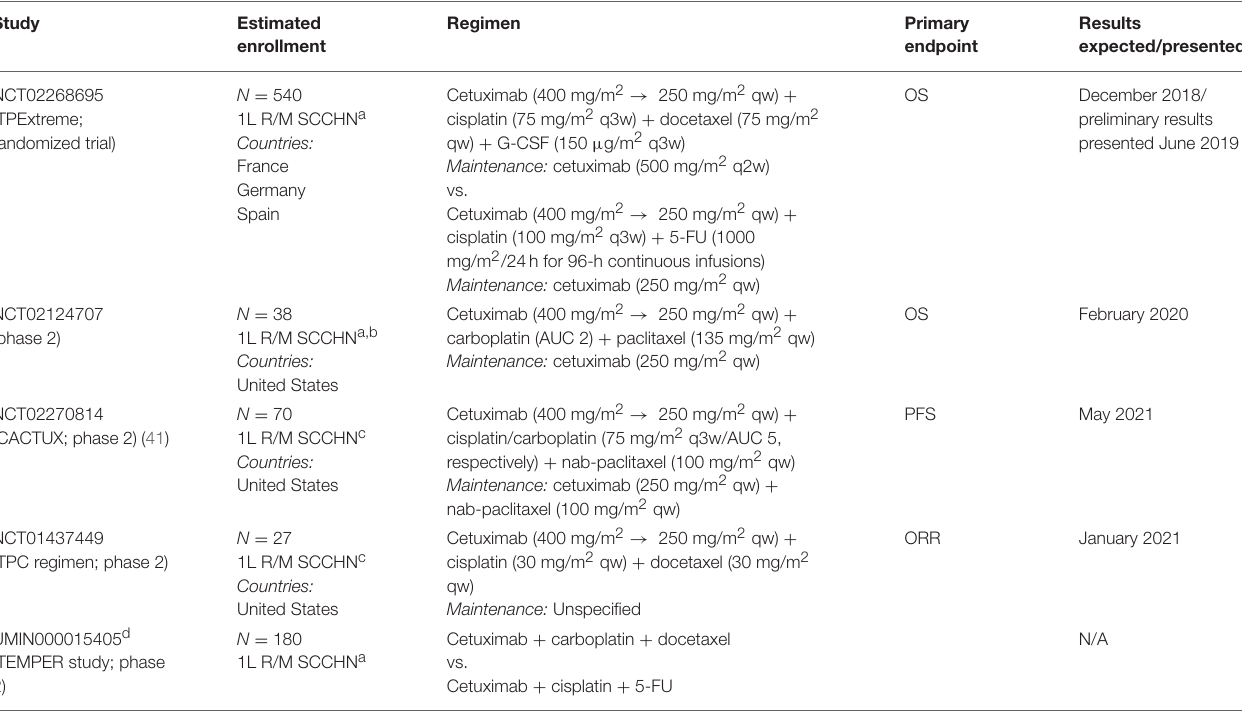
TABLE 2 | Ongoing studies of cetuximab + platinum + taxane regimens in first-line R/M SCCHN. Study Estimated Regimen Primary enrollment